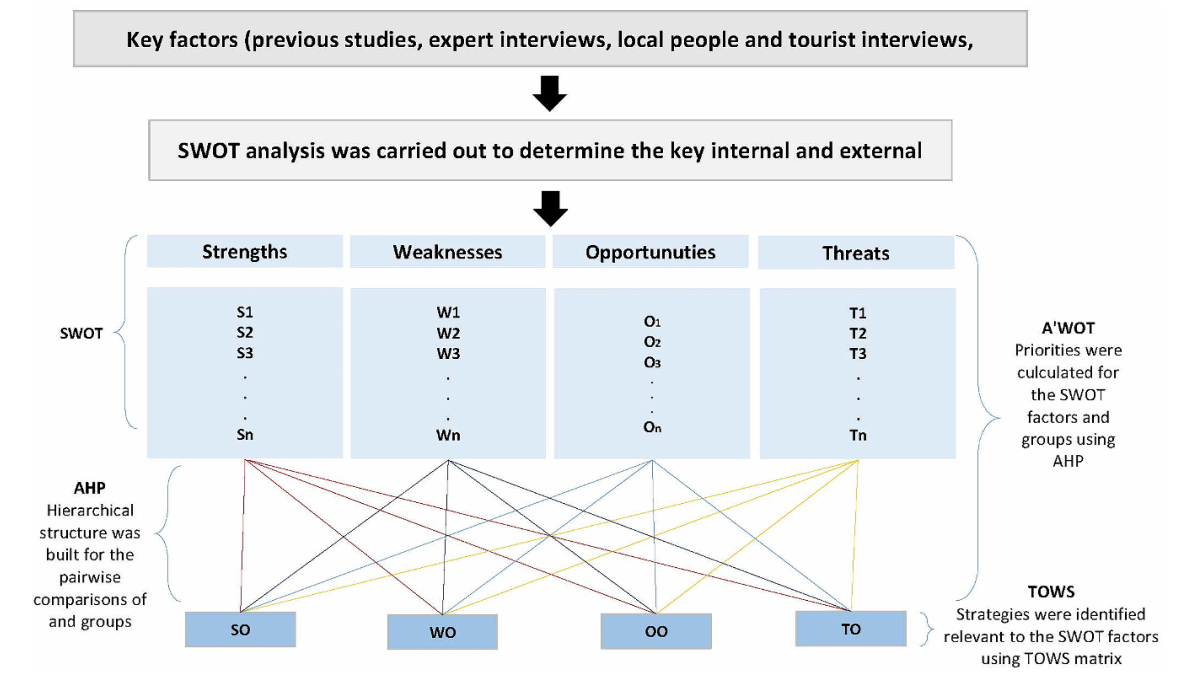
FIGURE2 The structure of the applied method (edit by authors from Asadpourian et al.,